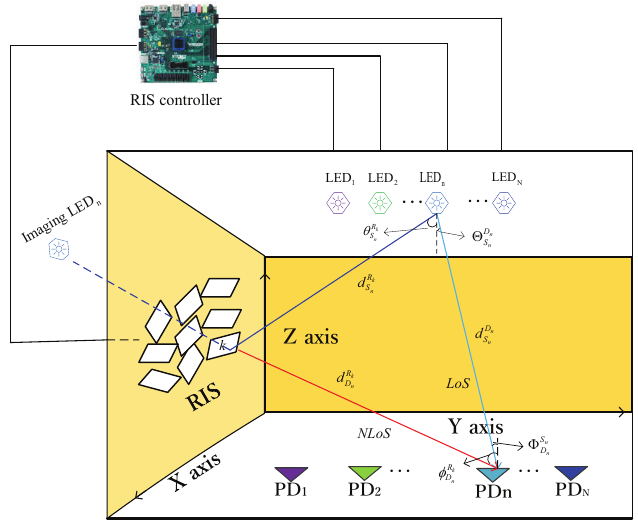
Figure 1. A typical RIS-aided parallel MIMO VLC